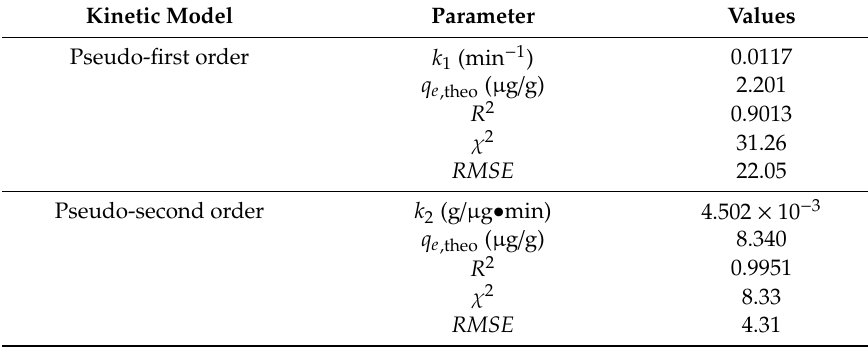
Figure 3. Experimental data fitted with ( a ) intraparticle diffusion, ( b ) pseudo-first order, ( c ) pseudo-second order, and ( d ) film diffusion equation for the adsorption of As(V) using CCB. Table 2. Values of coefficient of determination and kinetic parameters.